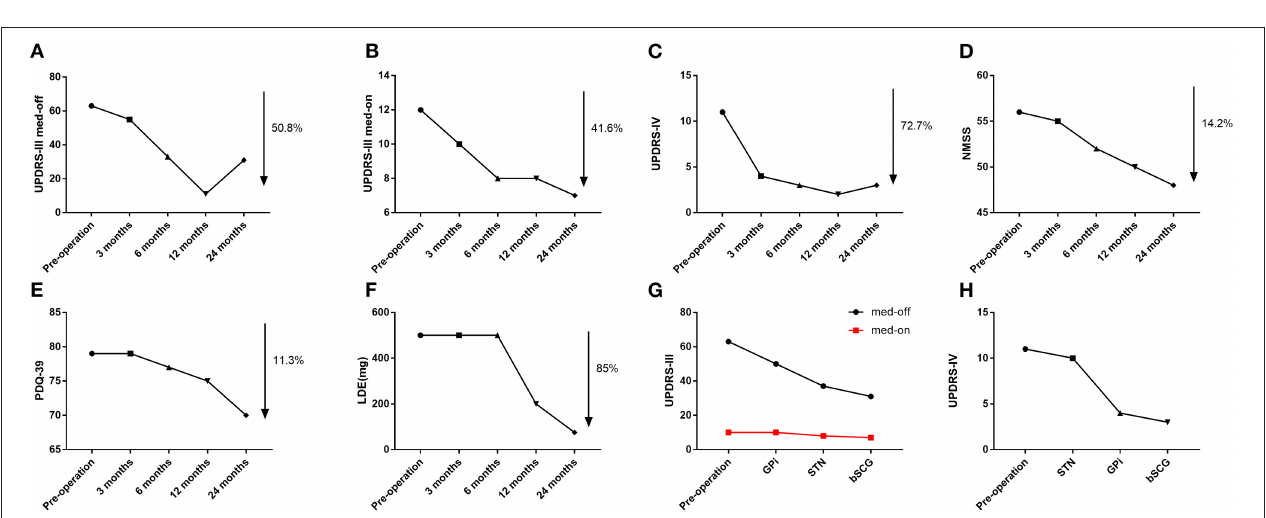
FIGURE 4 | (A) Trends in UPDRS-III off-period scores. (B) Trends in UPDRS-III on-period scores. (C) Trends in UPDRS-IV scores. (D) Trends in NMSS scores. (E) Trend in PDQ-39 scores. (F) Trends in Levodopa Equivalents (LDE). (G) Comparison of UPDRS-III score in 4 conditions (pre-surgery, GPi stimulation, STN stimulation, and combined GPi and STN stimulation). (H) Comparison of UPDRS-IV score in 4 conditions (pre-surgery, GPi stimulation, STN stimulation, and combined GPi and STN